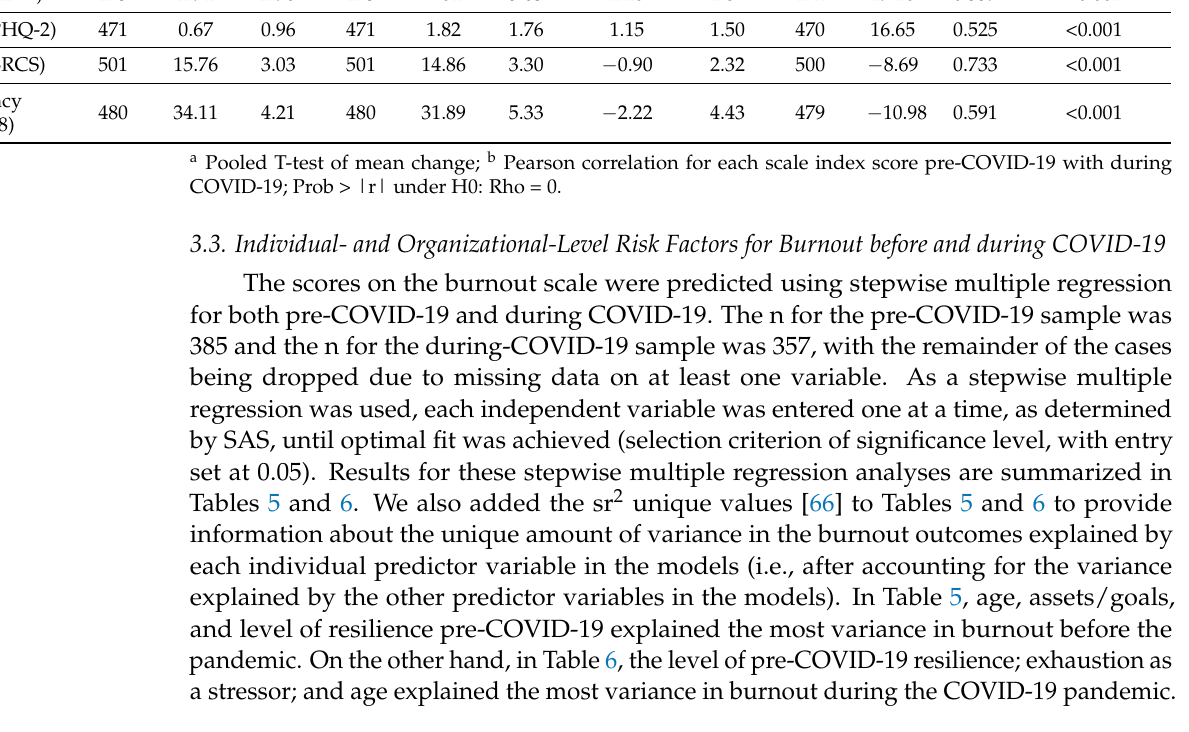
Table 5. Variables associated with burnout pre-COVID-19 (multiple